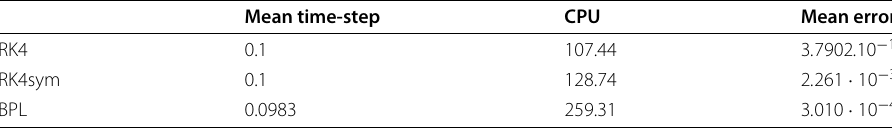
Table 1 Toda lattice